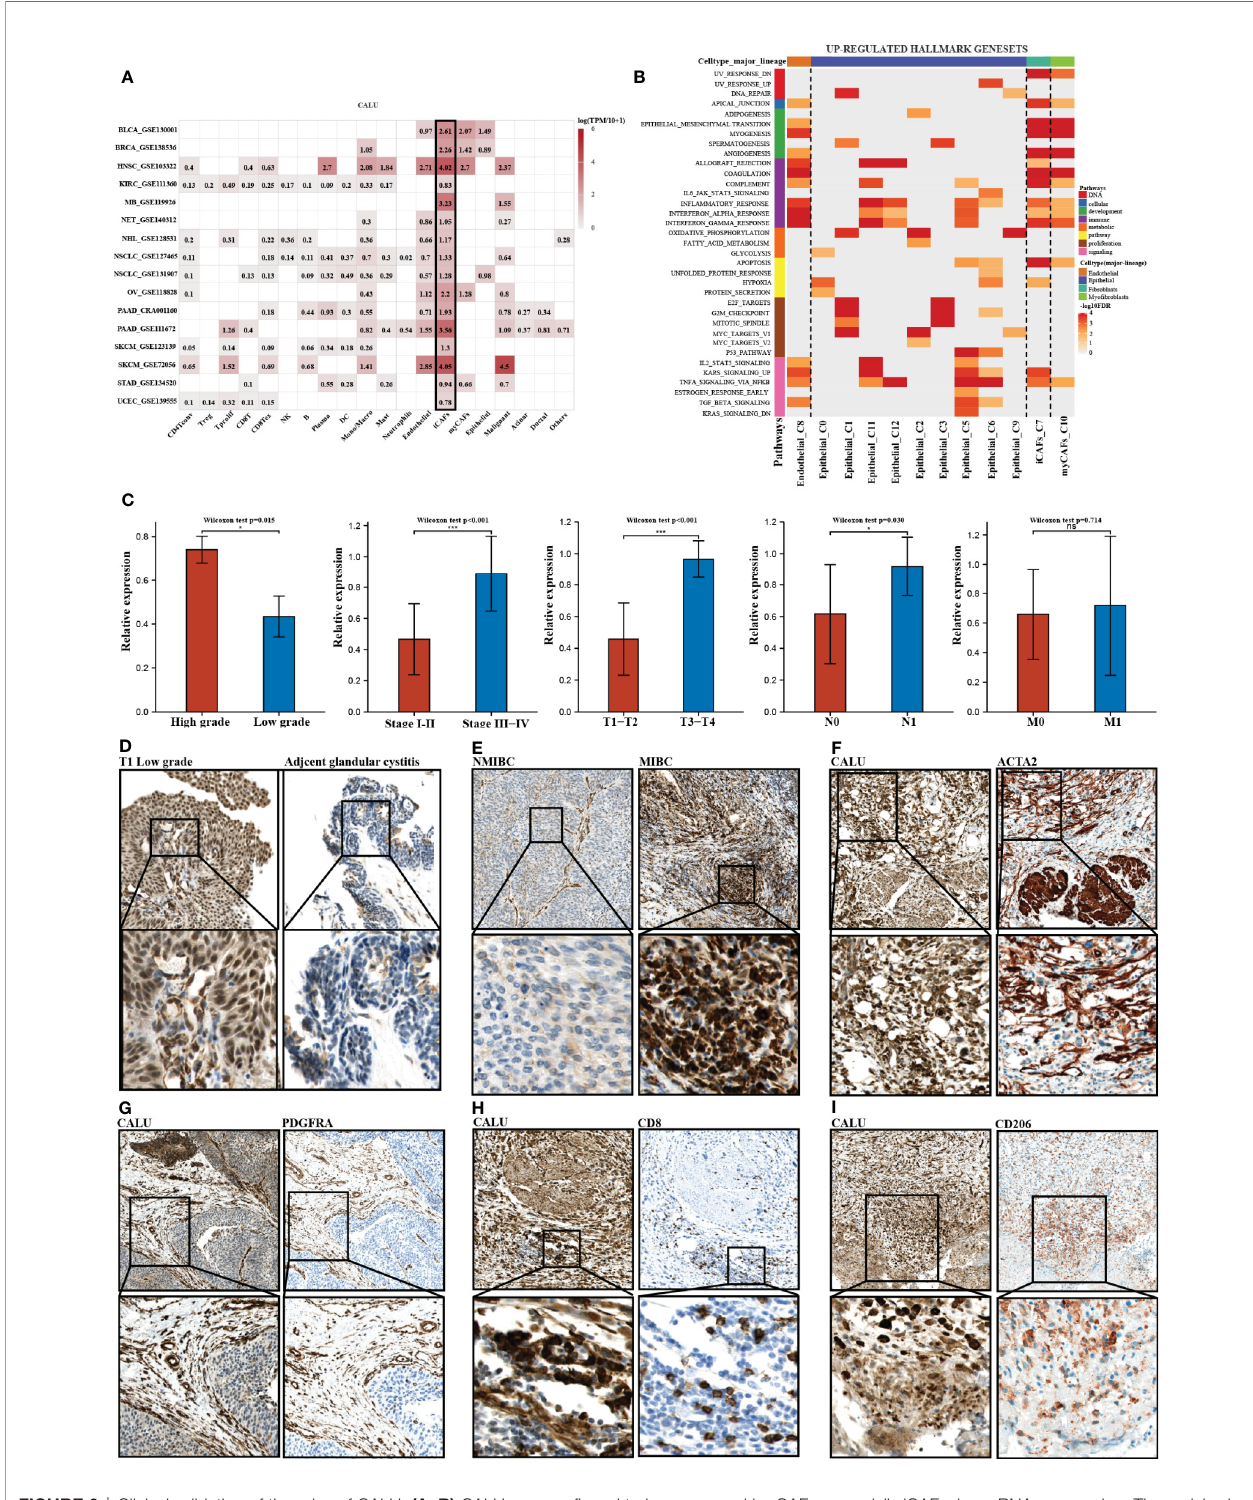
FIGURE 9 | Clinical validation of the roles of CALU. (A, B) CALU was con fi rmed to be expressed by CAFs, especially iCAFs, by scRNA sequencing. The enriched hallmark gene sets by iCAFs were highly corresponded with the genesets which TCGA CALU high group enriched. (C) PCR analysis con fi rmed the differential expression of CALU in tumors with different grades (p<0.05), stages (p<0.001), and T (p<0.001), N (p<0.05) classi fi cations. (D, E) Immunohistochemical analysis indicated that CALU levels were higher in BLCA than in GC, while CALU levels were higher in MIBC than in NMIBC. (F, G) CALU co-expressed with ACTA2 (F) and PDGFRA (G) by stromal components (H, I) Co-expressions of CALU, CD206 and CD8 were observed in MIBC samples. ***p<0.001, *p<0.05. NS, not signi fi